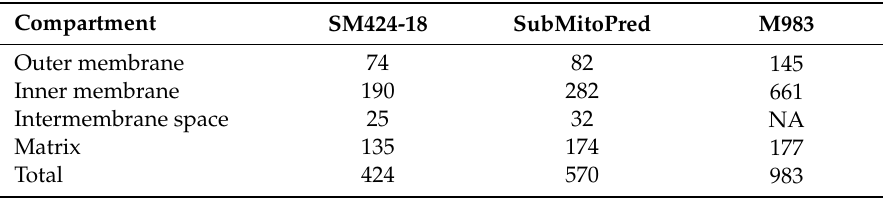
Table 5. The feature of